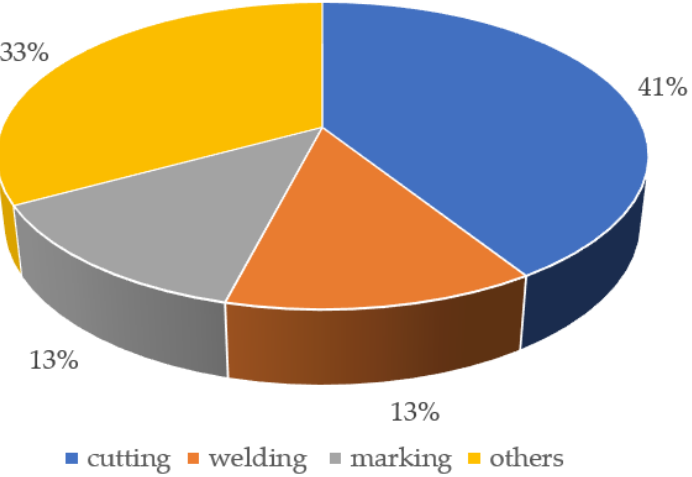
Figure 1. Industrial laser processing application distribution in China in 2021.